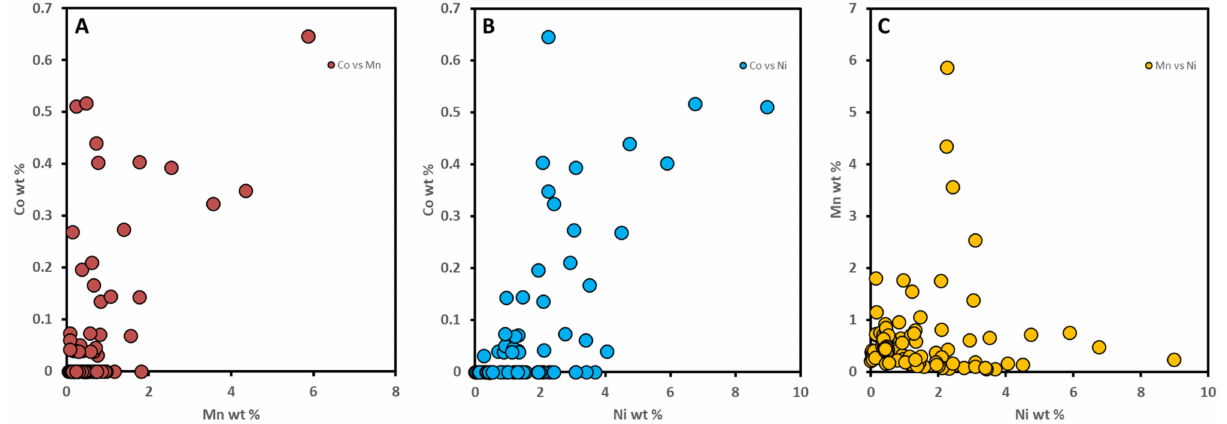
Figure 12. Relationship between ( A ) Co and Mn, ( B ) Co and Ni, and ( C ) Ni and Mn as measured by EMPA in goethite grains from the saprolitic units of the Piau í